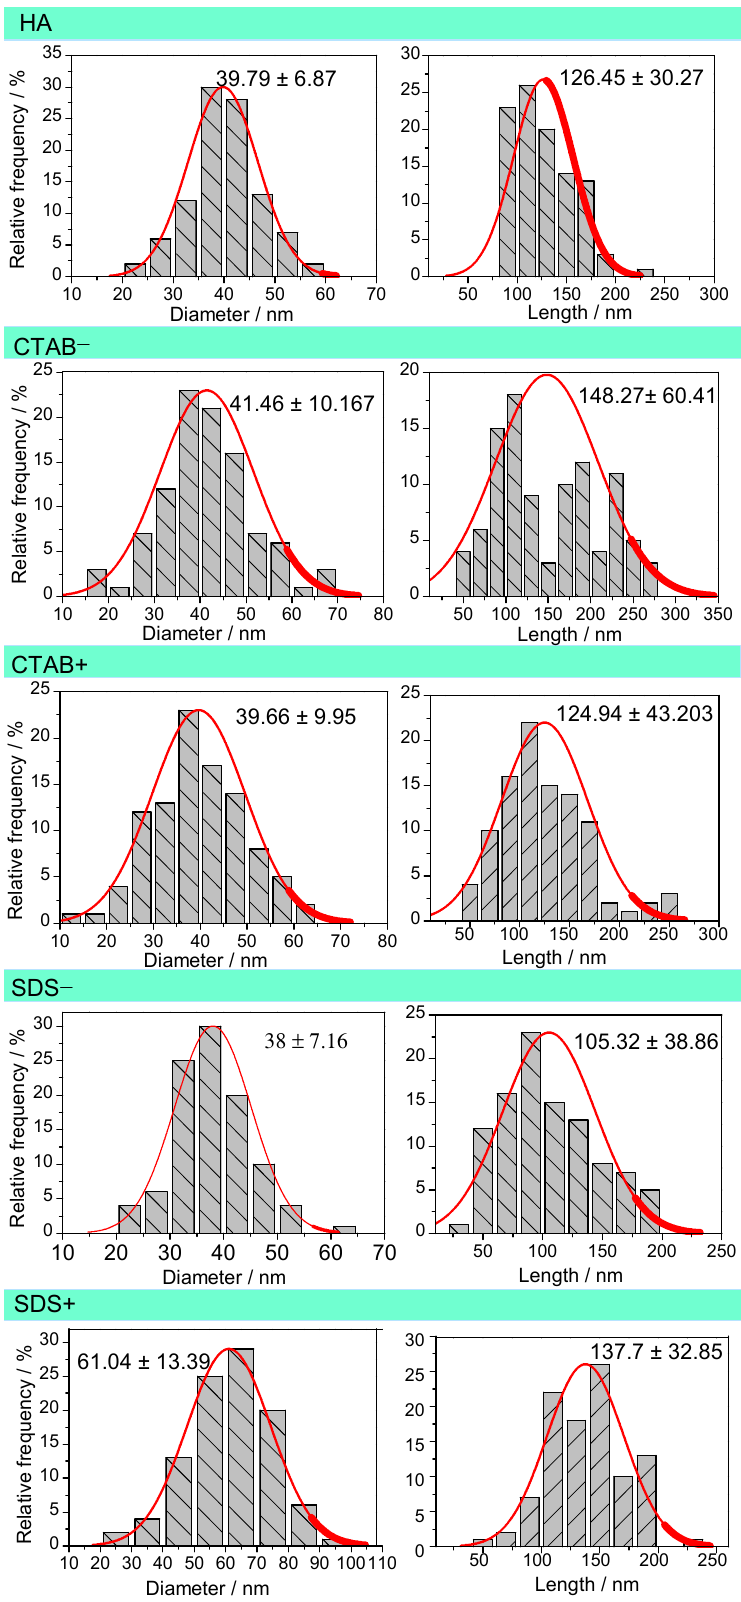
Figure 4. Diameter and length distributions of the HA, CTAB − , CTAB+, SDS − , and SDS+ samples. The numerical values report the mean and standard deviation of 100 measurements.